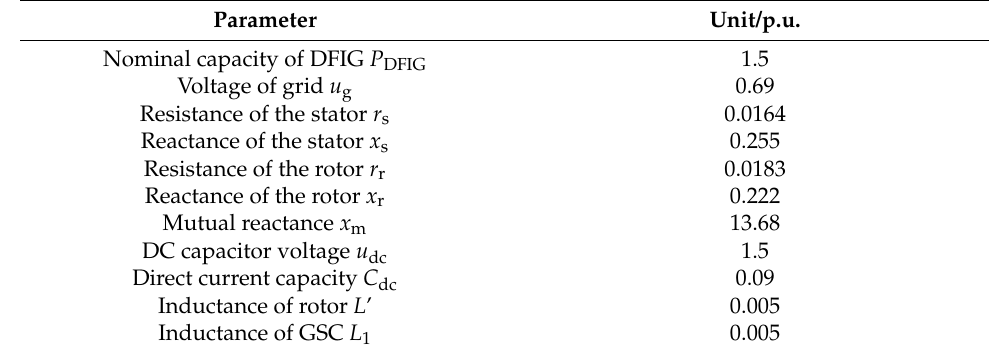
Figure A1. The transfer function of AC1A. Table A10. Main parameters of the DFIG.